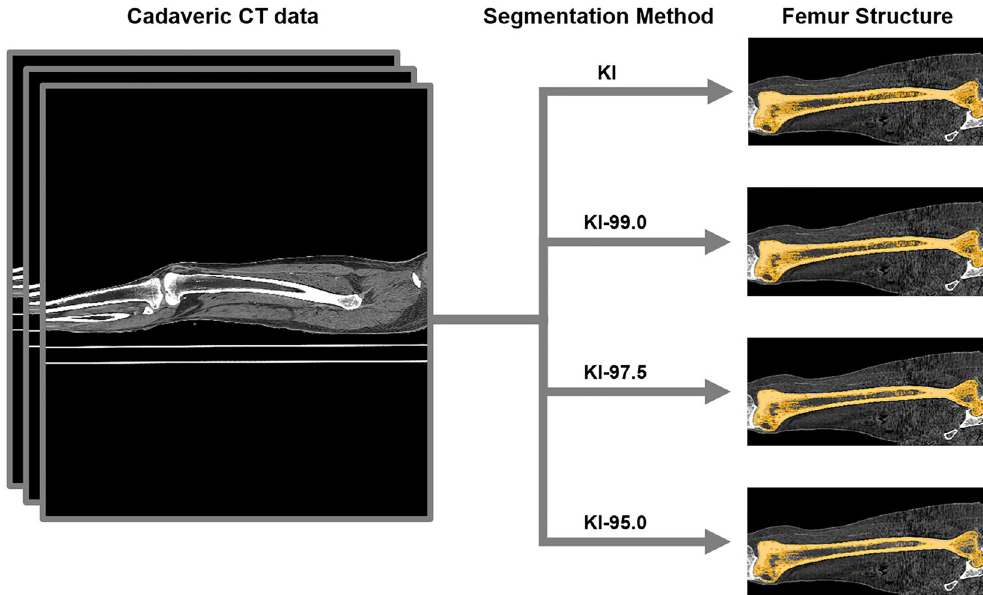
Figure 1. Overview of cadaveric CT data segmentation used to extract series of 3D anatomical models of femur structure. Segmentation methods: Kittler–Illingworth algorithm (KI), 99.0% intermediate intensity value thresholding approach (KI-99.0), 97.5% intermediate intensity value thresholding approach (KI-97.5), 95.0% intermediate intensity value thresholding approach (KI-95.0). Segmented femur osteological structure is shown in orange, coronal